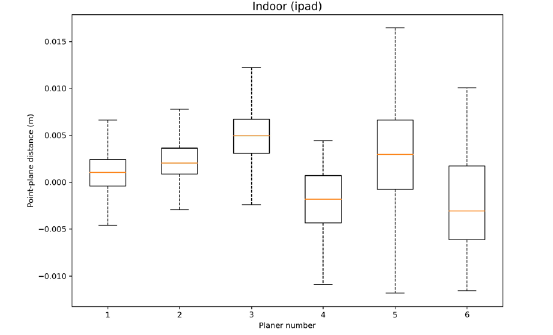
Figure 5 . Distribution of point-plane distances for the 6 planes tested from the iPad Pro point cloud.